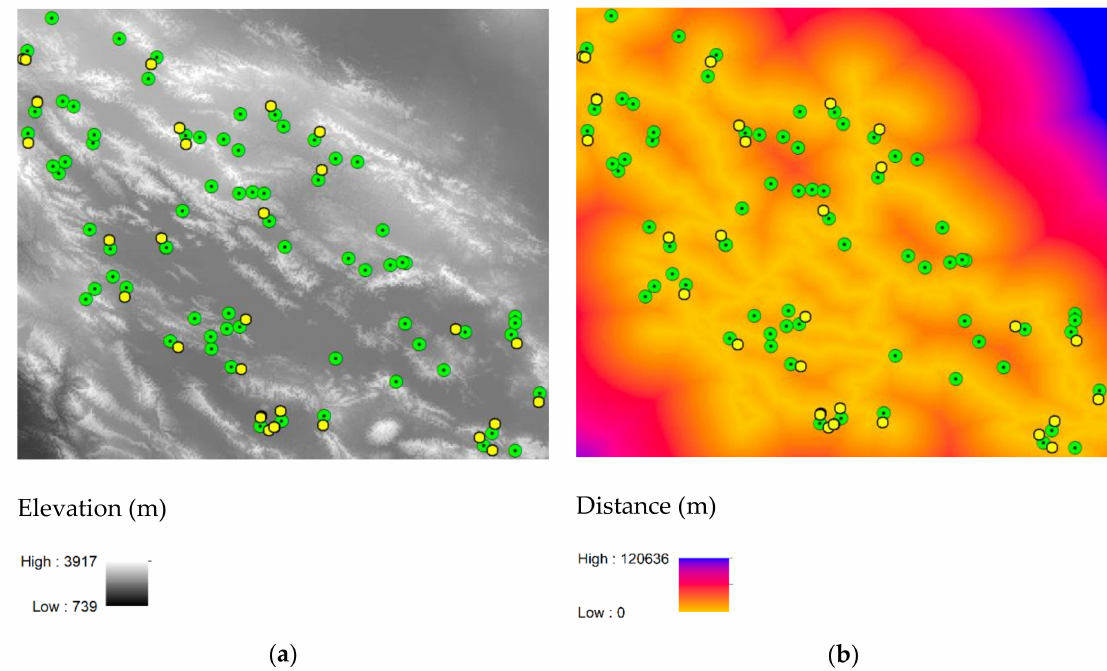
Figure 11. Final results map of error correlation and environmental effects: ( a ) digital elevation model (DEM) of the study area. ( b ) Distance from roads map.